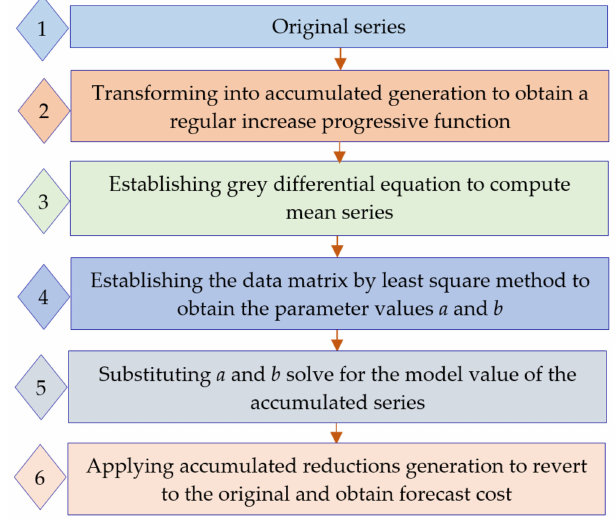
Figure 10. Forecasting process (Nguyen Han Khanh 2021)